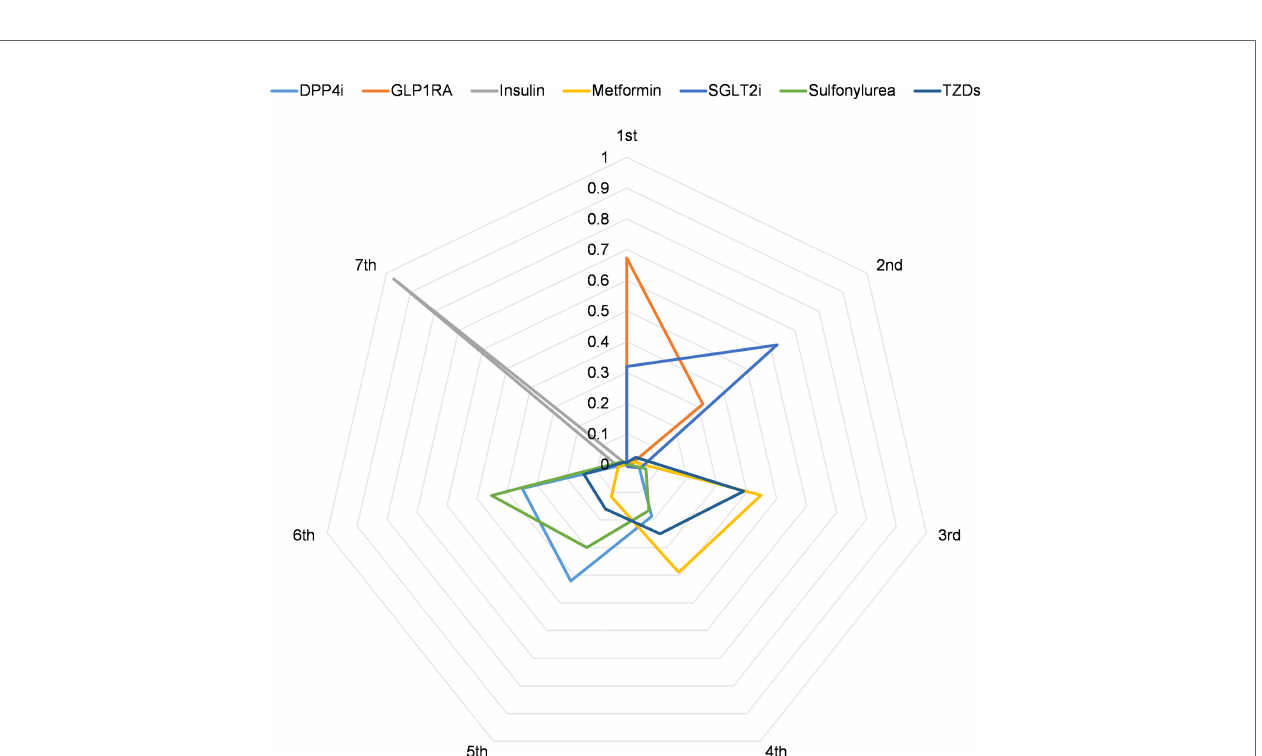
FIGURE 5 | Radar plot of the ranking probability for COVID-19